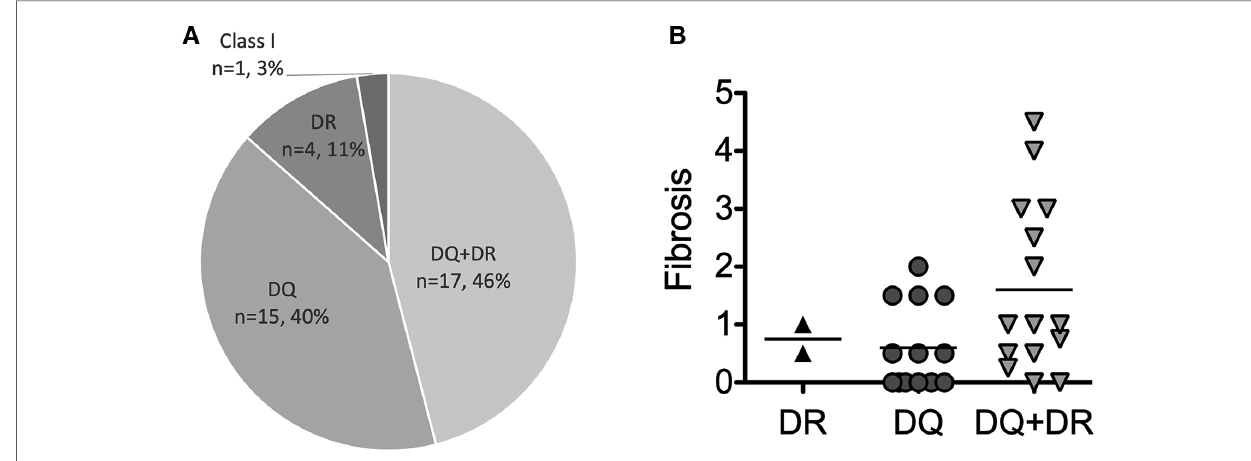
FIGURE 2 The type of post-transplant DSA. ( A ) The frequencies of types of post-transplant DSA among pediatric LT recipients ( n =37). ( B ) The correlation between the type of post-transplant DSA and graft fi brosis among the pediatric LT recipients who had available data histologically evaluated by liver biopsies ( n = 32). The values of DSA-MFI and histological fi ndings were collected at the time of the fi rst detection of post-transplant DSA.